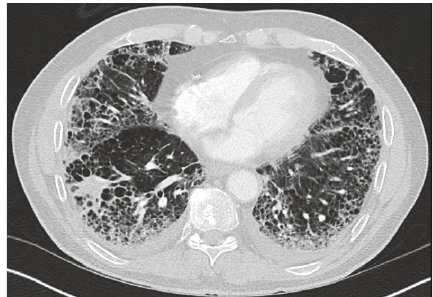
Figure 2: Chest Computed Tomography (CT) angiogram obtained to rule out pulmonary embolism (PE) showed diffuse bilateral pulmonary infiltrates, mediastinal lymphadenopathy, and small bilateral pleural effusions.